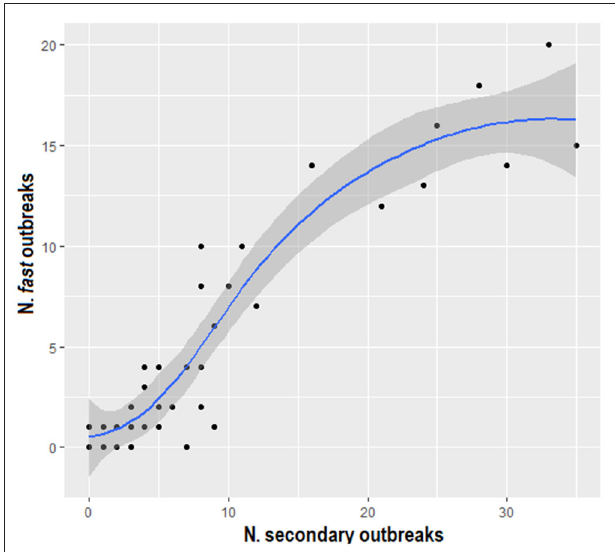
FIGURE 8 | Scatter plot displaying the number of fast outbreaks versus the number of secondary outbreaks, using both the nearest-neighbor and the uniform kernel functions.